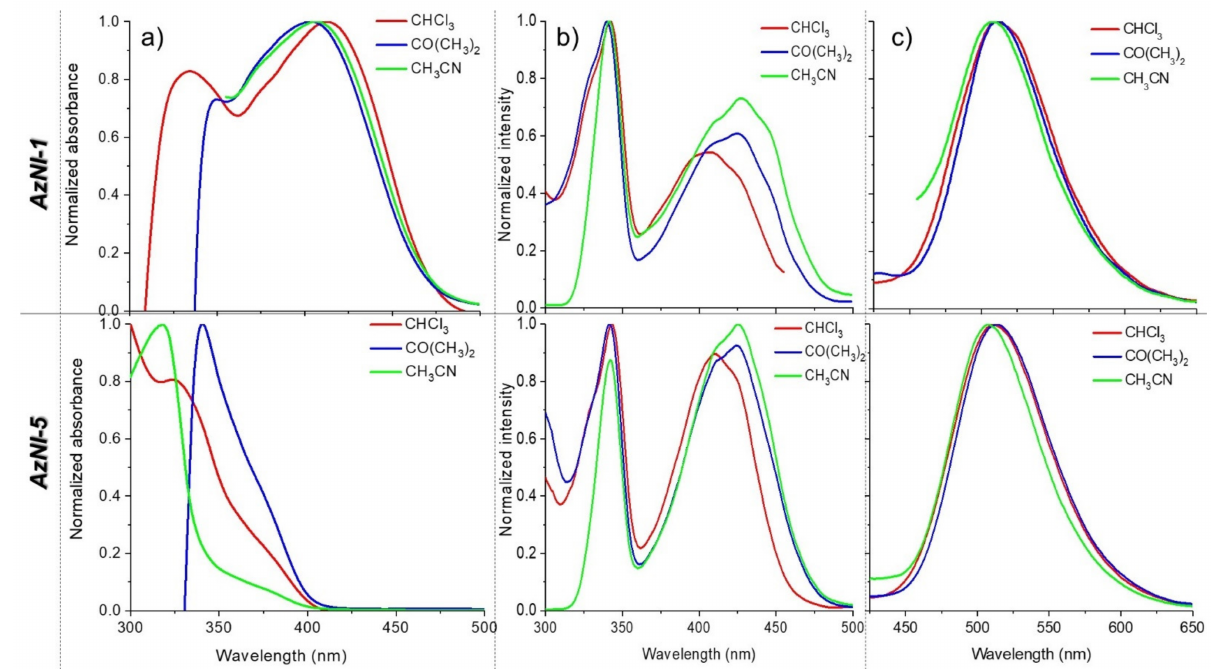
Figure 6. The ( a ) electronic absorption, ( b ) excitation, and ( c ) emission ( λ ex = 340 nm) spectra of AzNI–1 and AzNI-5 in various